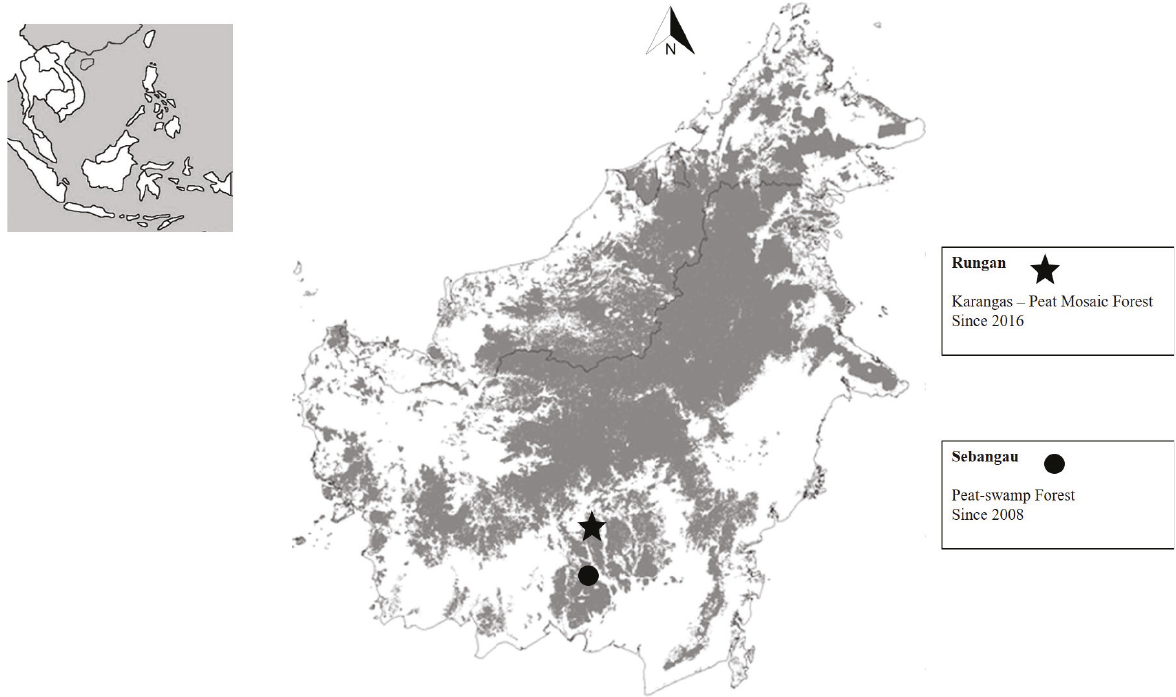
Figure 1. Study sites: circle - Sebangau; star - Rungan.